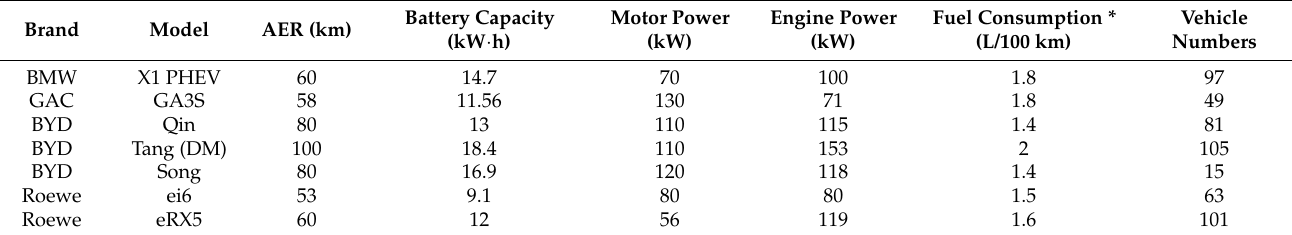
Table 1. Vehicle attributes used in this research.